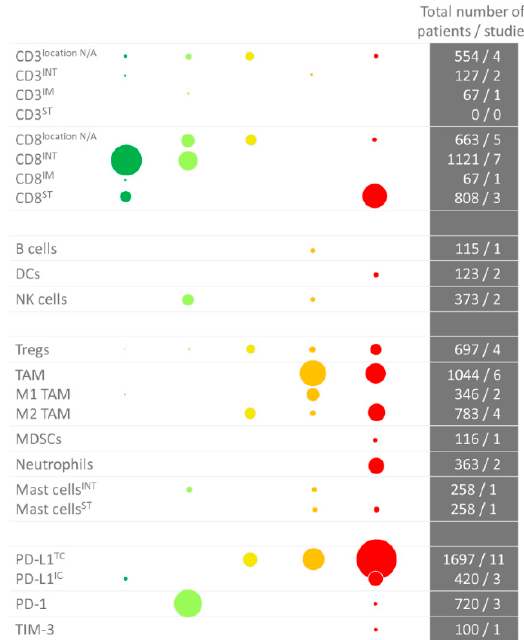
Figure 2. Overview of immunohistochemistry studies in bladder cancer per immune cell type. The color (and position) indicate whether there was a positive or negative correlation. Dark green: significant positive correlation; light green: trend towards a positive correlation; yellow: no trend; orange: trend towards a negative correlation; red: negative correlation. The size of the dots indicates the number of studied patients. As some studies performed an analysis in more than one cohort, the number of dots is sometimes higher than the total number of studies (i.e., for the Tregs). Abbreviations: DCs: dendritic cells; IC: immune cell; INT: intraepithelial; IM: invasive margin; MDSCs: myeloid-derived mononuclear cells; N / A: not applicable; NK cells: natural killer cells; PD-(L)1: programmed death (ligand)-1; ST: stroma; TAM: tumor-associated macrophage; TC: tumor cell; TIM-3: T-cell immunoglobulin mucin-3; Tregs: regulatory T cells.